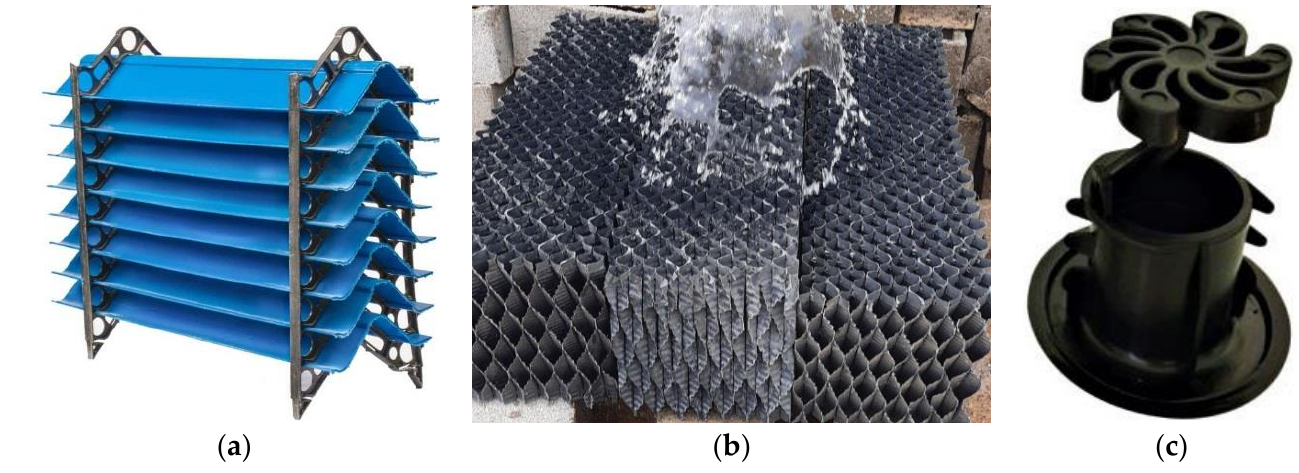
Figure 3. ( a ) Drift eliminator, ( b ) packing and ( c ) nozzle that used in the humidification